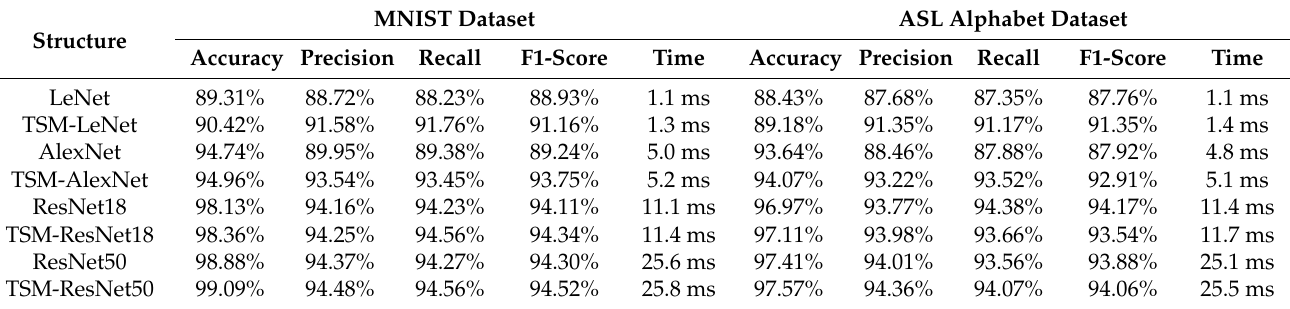
Table 6. Results Comparison of TSM-CNNs.